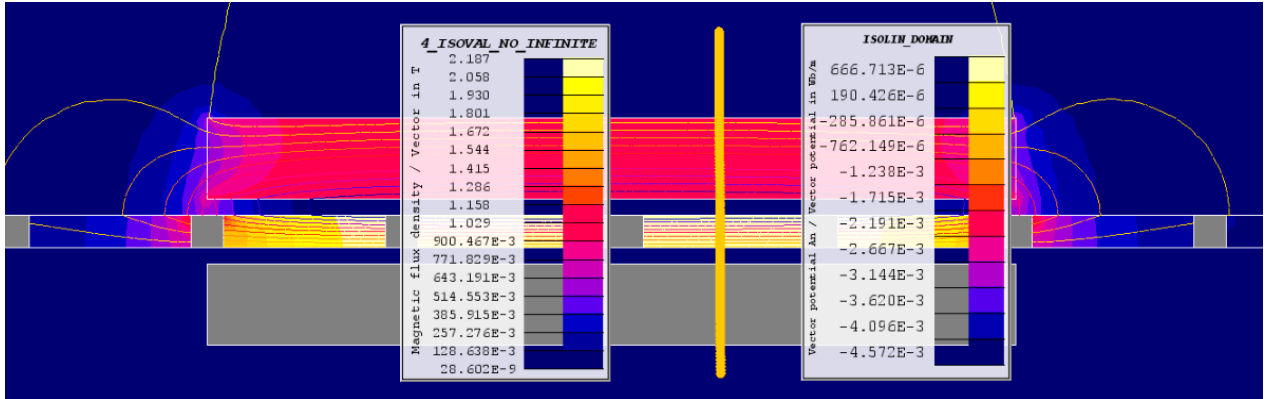
Figure 23. Establishment of the analysis route for the study of magnetic flux density.